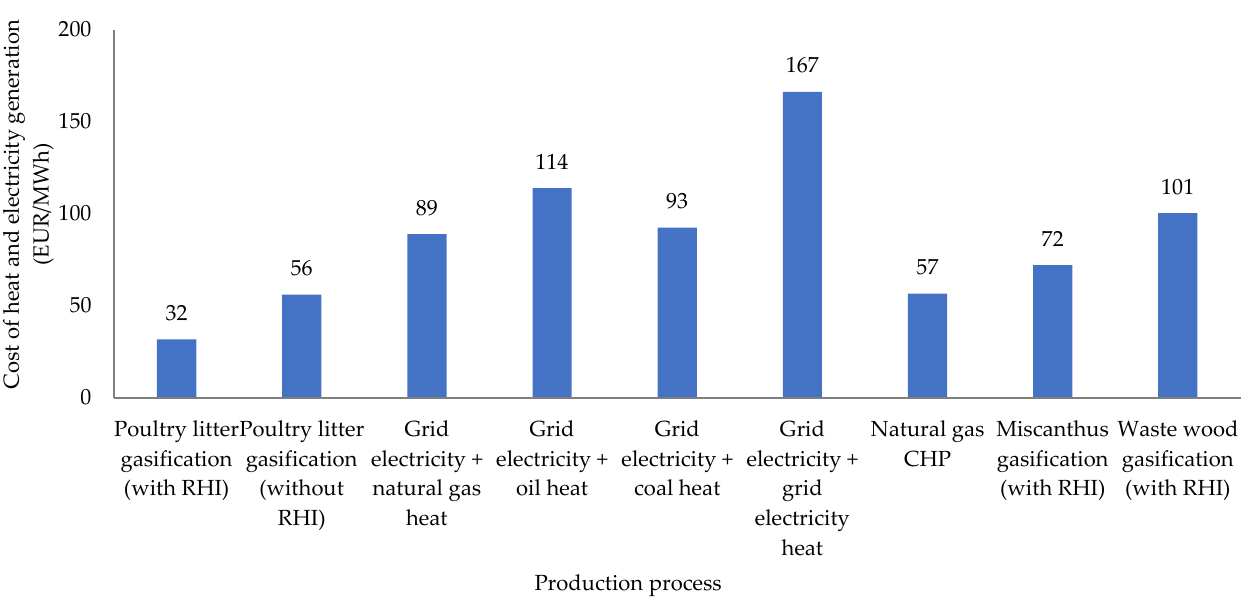
Figure 7. Comparison of the energy costs of gasification of chicken litter with biomass and fossil fuels. (1 MWh comprises 0.4 MWh of electricity and 0.6 MWh of heat) (adapted from [70]). Original data presented in GBP/t and converted to EUR/t (GBP 1 = EUR 1.16761 according to [71]).